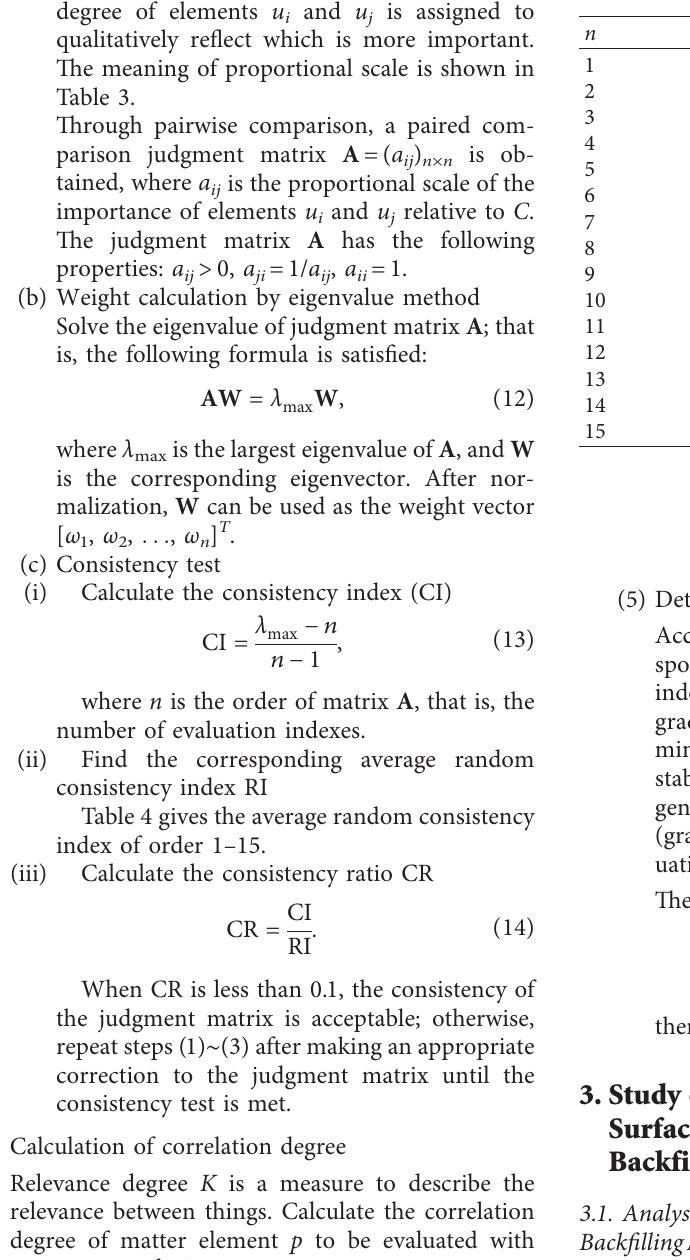
Table 4: RI value